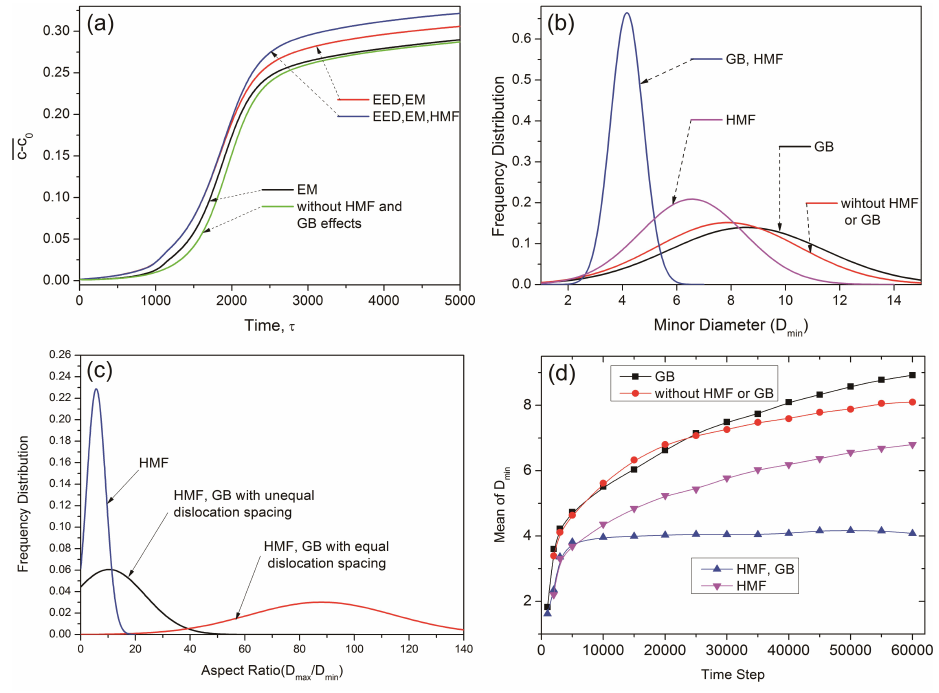
Figure 7. Plots of ( a ) change of average concentration c − c 0 against time; ( b ) Frequency distribution of minimum diameter ( D min ); ( c ) Frequency distribution of aspect ratio ( D max / D min ); ( d ) mean minimum diameter ( D min ) against time.